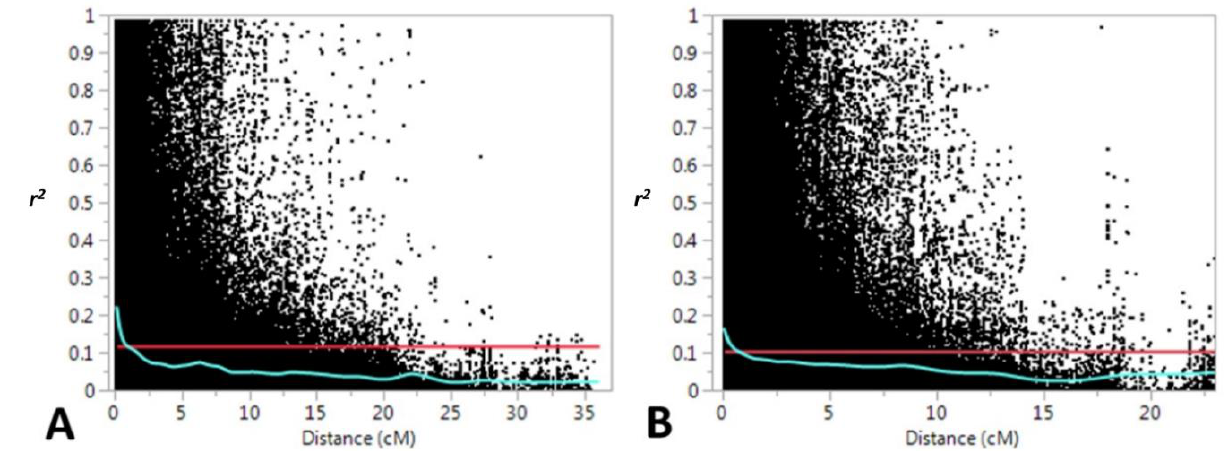
Figure 1. Linkage disequilibrium plots for ( A ) genome A; ( B) genome B. The locally estimated scatterplot smoothing (LOESS) curve is represented in blue. The red line represents the mean value for the square of marker correlations ( r 2 ).